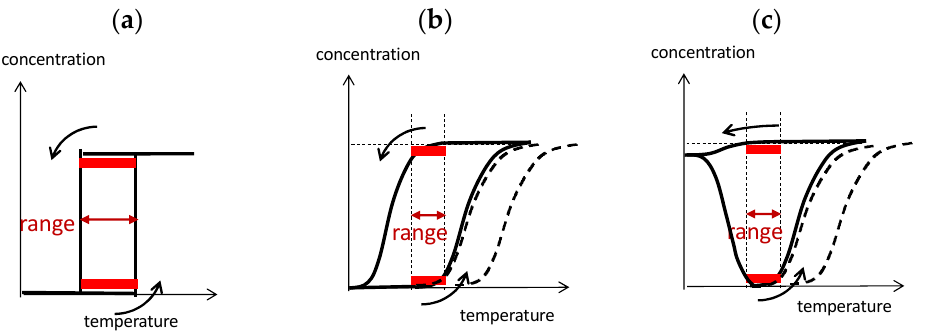
Figure 6. Bistability by thermal hysteresis involving ( a ) the Heaviside step relationship, ( b ) and ( c ) sigmoidal relationships shown by temperature/concentration profiles. Bold red lines indicate the temperature ranges of bistability with tolerance. Dashed lines indicate the examples of chemical equilibrium. Black arrows indicate cooling and heating.